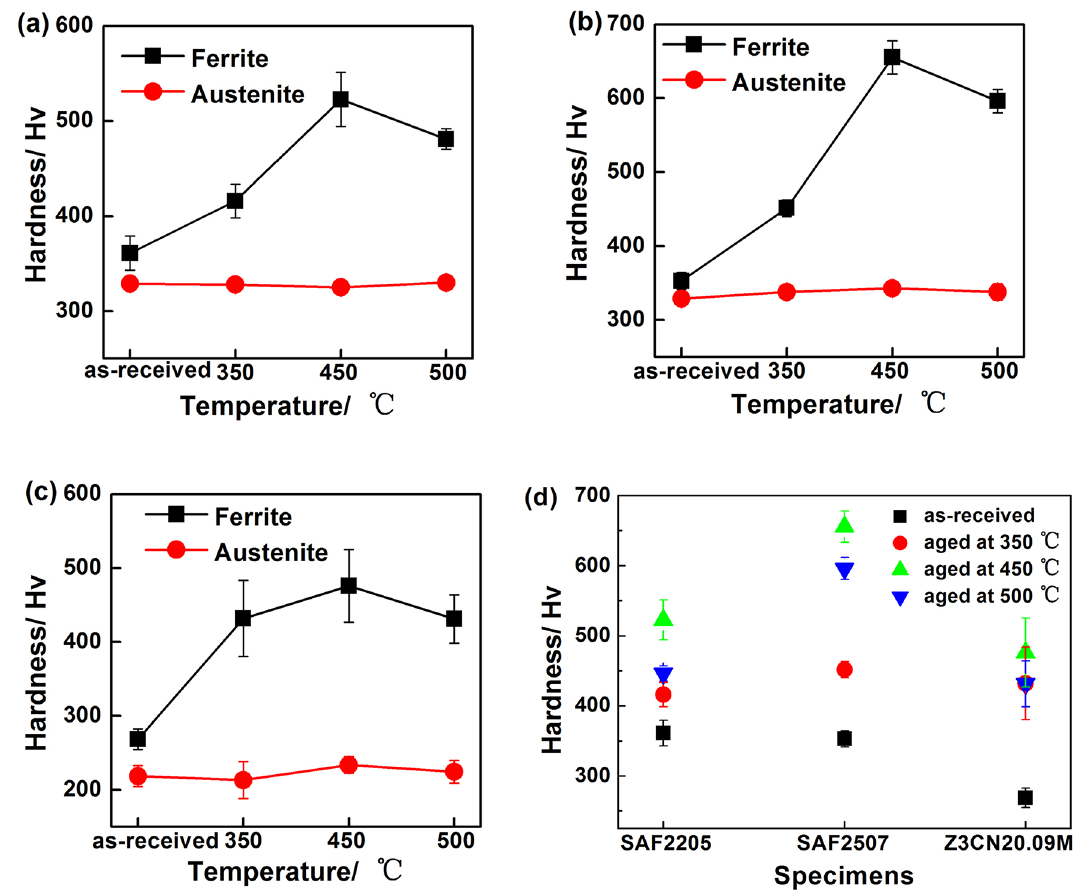
Figure 4. The changes in microhardness of three thermally aged DSS specimens with thermal ageing temperature (a) SAF2205, (b) SAF2507, (c) Z3CN20.09M and (d) hardness of ferrite in different thermally aged DSS specimens SAF2507 specimens decreased firstly and then